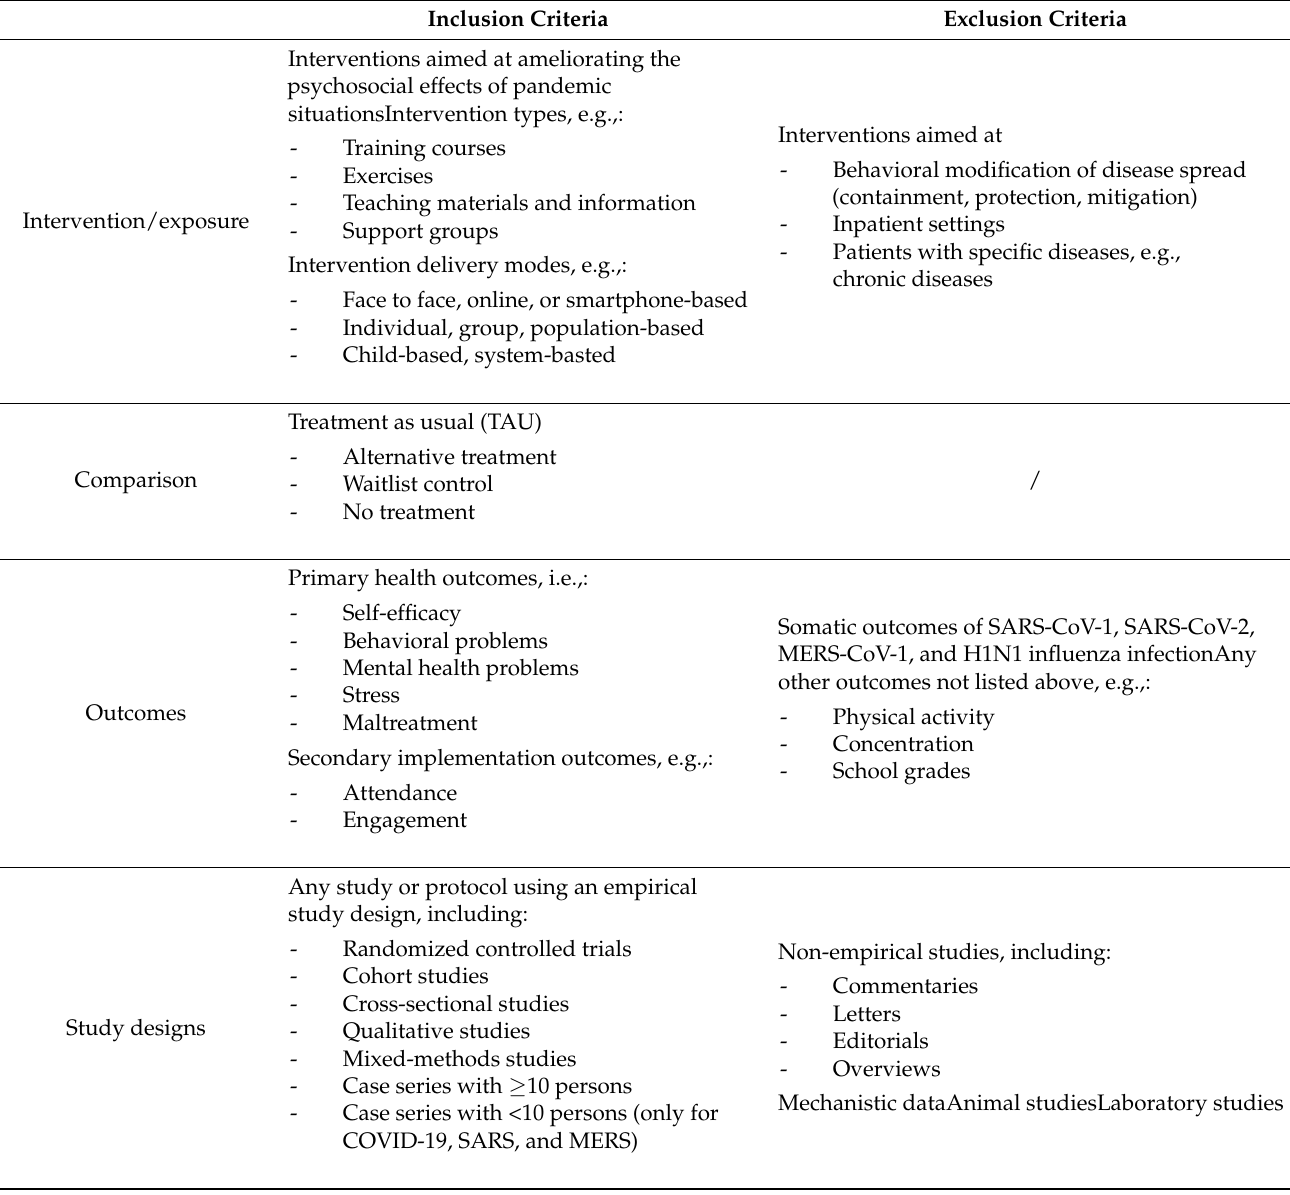
Table 1. Cont. Inclusion